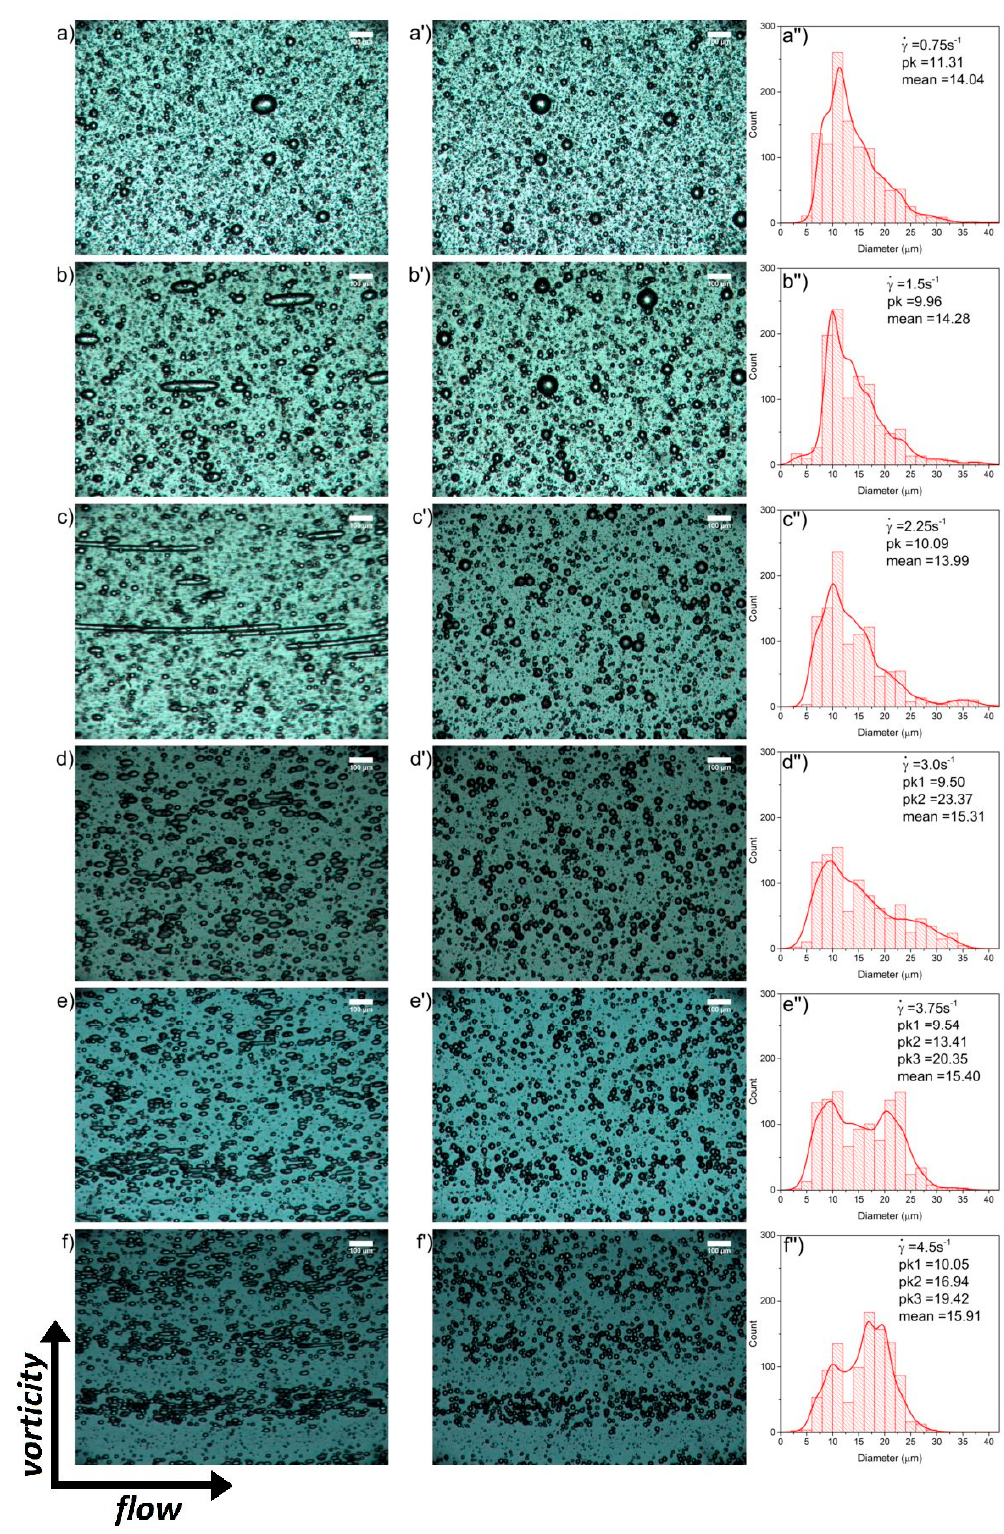
Figure 2. The sequence of images shows the effects due to increase of shear rates (top to bottom) on the evolution of the morphology—during flow, left, unprimed letters ( a – f ); after cessation of flow ( a’ – f’ ), center, and primed letters—for a (50/50) emulsion. For histograms—right plots, double primes ( a’’ – f’’ )— pk n stands for the first, second, etc., peak of the distribution; mean is the average size of drops. All images are captured with the same magnification and at a temperature of 30 °C.